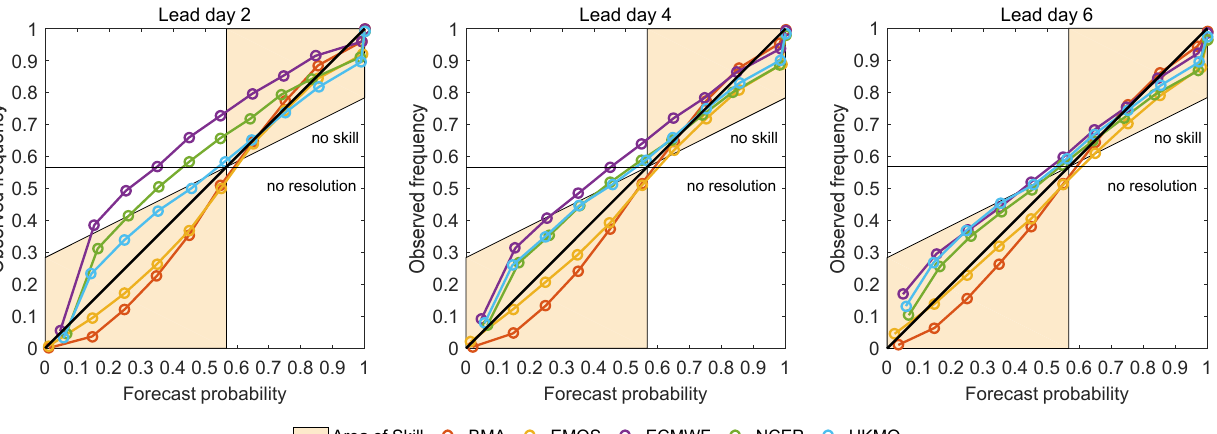
Figure 7. Reliability diagram of the binned probabilistic forecast versus the observed relative frequency of the 500 hPa geopotential height higher than its climatology value for consensus voting of the raw ensemble, BMA and EMOS forecasts with a lead time of 1 day. The black diagonal line is the perfect forecast.